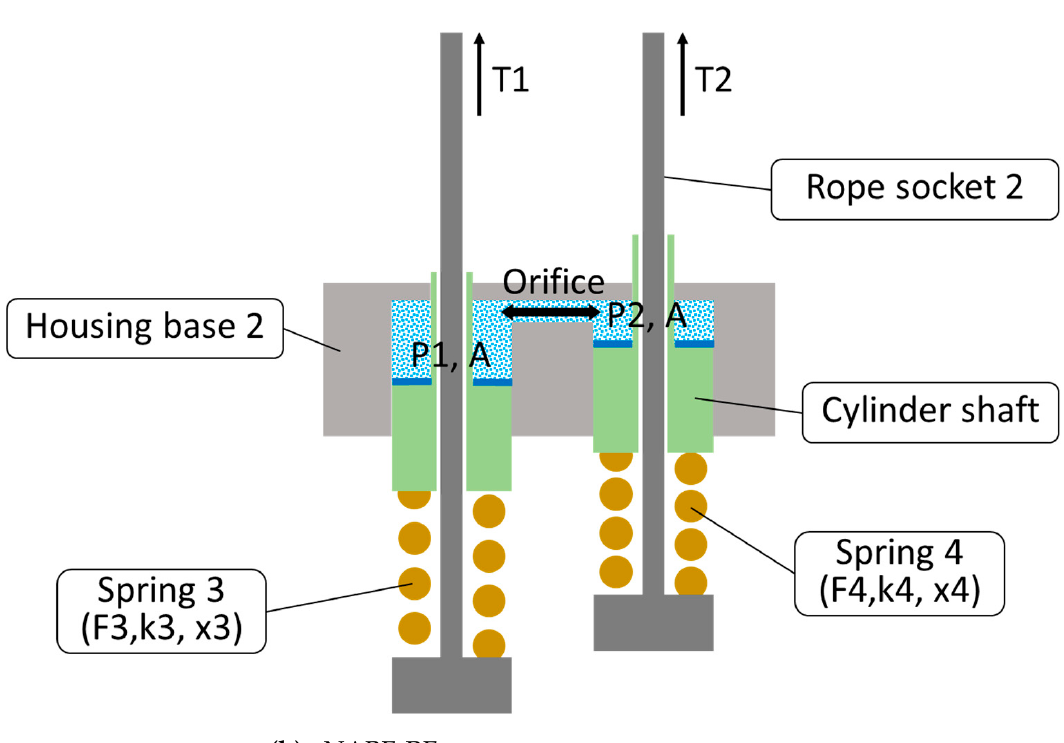
Figure 1. Schematic diagrams of the conventional spring socket and the NABE-RE.